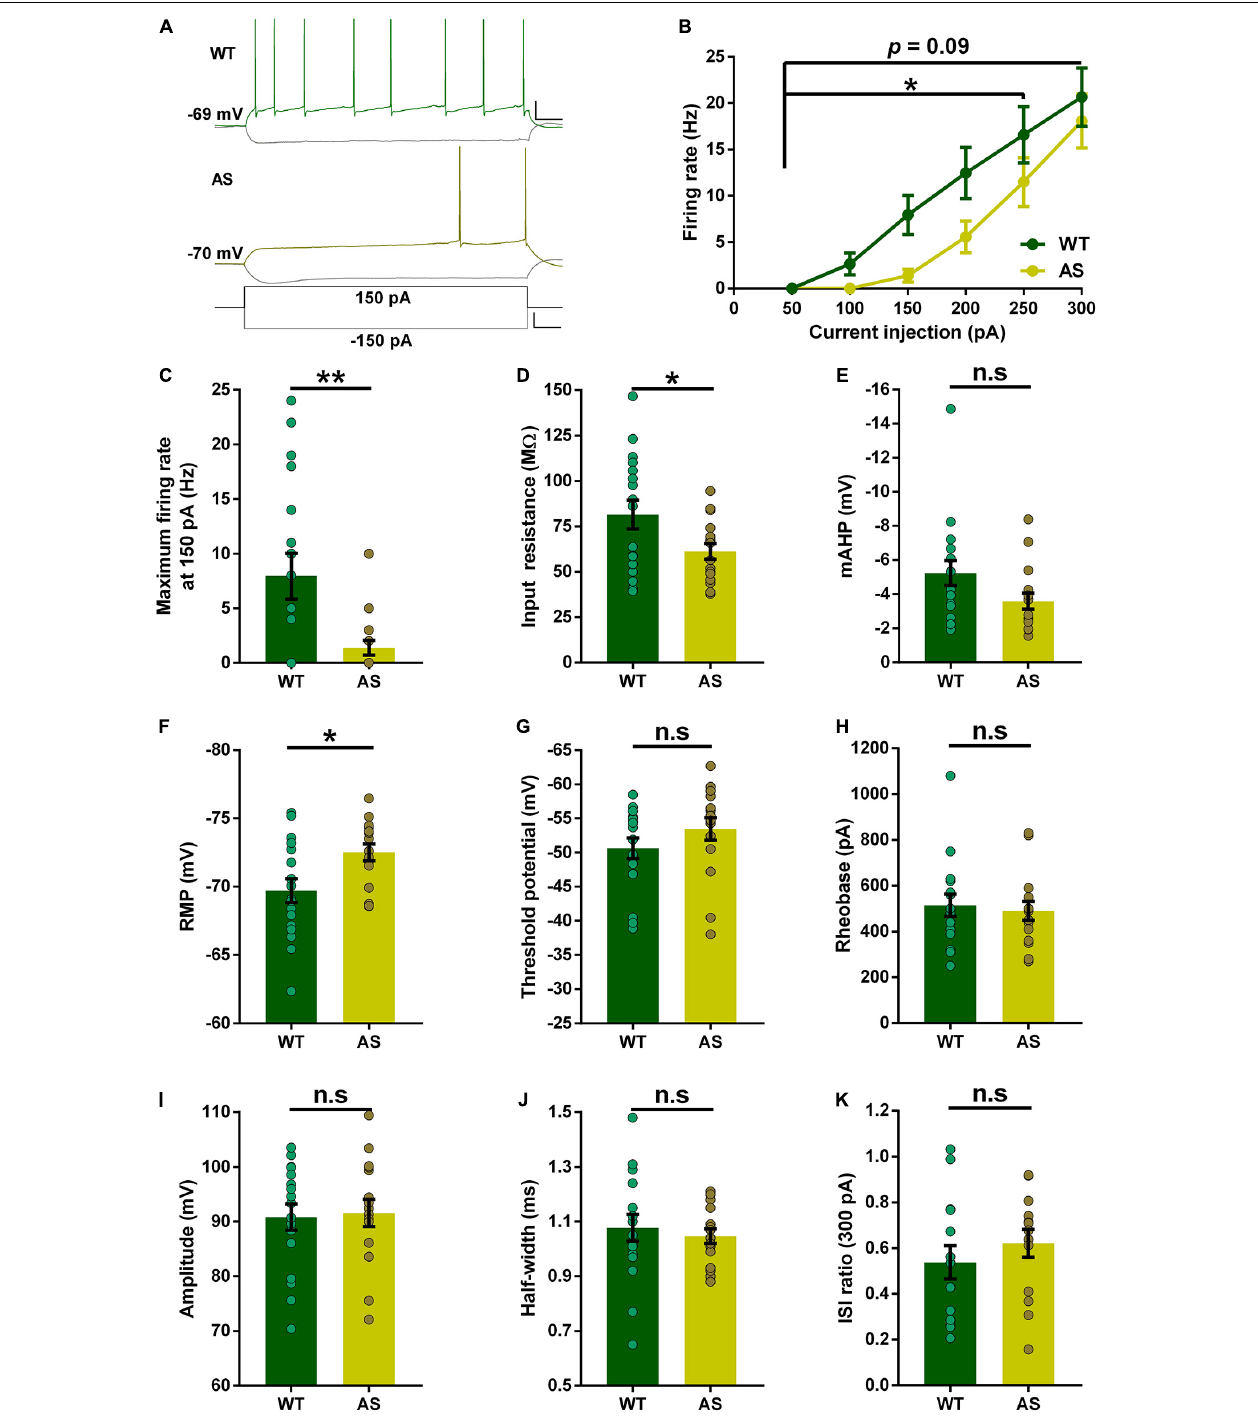
FIGURE 2 | Partial alterations in the passive and active membrane properties of subicular RF PNs. (A) Representative traces of responses to a 150 pA depolarizing and –150 pA hyperpolarizing current injection in subicular RF neurons of WT (green), and AS (olive) mice. Scale: 20 mV, 100 ms. The bottom trace represents the step current used to elicit the above responses. Scale: 100 pA, 100 ms. (B) Firing frequency of all RF neurons in response to different somatic current injection steps ranging from 50 to 300 pA. The overall firing frequency of AS mice was significantly lower compared to their WT counterparts during 50–250 pA current injection [ F ( 1 , 31 ) = 4.50, p = 0.04 for main effect of genotype; F ( 4 , 124 ) = 2.47, p = 0.04 for interaction of genotype and current injection in two-way RM ANOVA]. However, at higher current injection of 300 pA, the firing frequency remains unaltered in AS mice [ F ( 1 , 31 ) = 2.92, p = 0.09 for main effect of genotype; F ( 5 , 155 ) = 1.82, p = 0.11 for interaction of genotype and current injection in two-way RM ANOVA]. (C–K) Aligned dot plots of passive and active membrane properties of RF neurons. (C) The